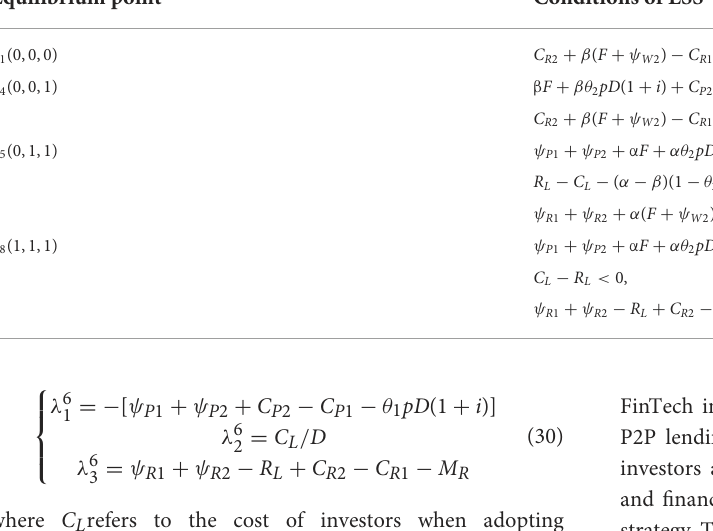
TABLE 4 Stability conditions of the equilibrium points. Equilibrium point Conditions of